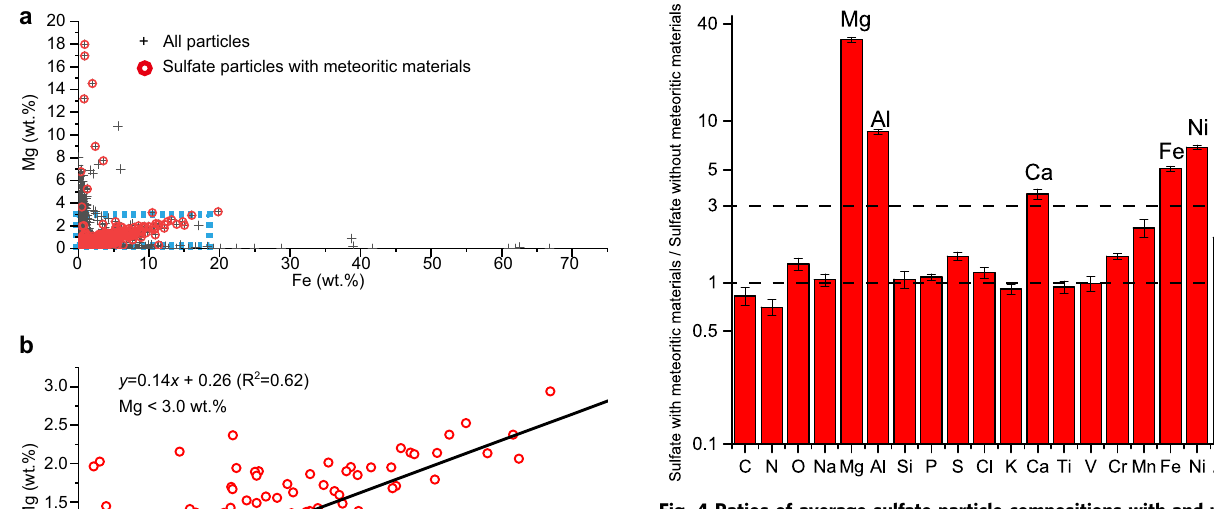
Fig. 4 Ratios of average sulfate particle compositions with and without meteoritic material. The ratios are shown on a logarithmic scale. Errors are shown at the 95% con fi dence interval. The number of sulfate particles with and without meteoritic material was 571 and 19,253, respectively. Dashed lines indicate ratios of 3 and